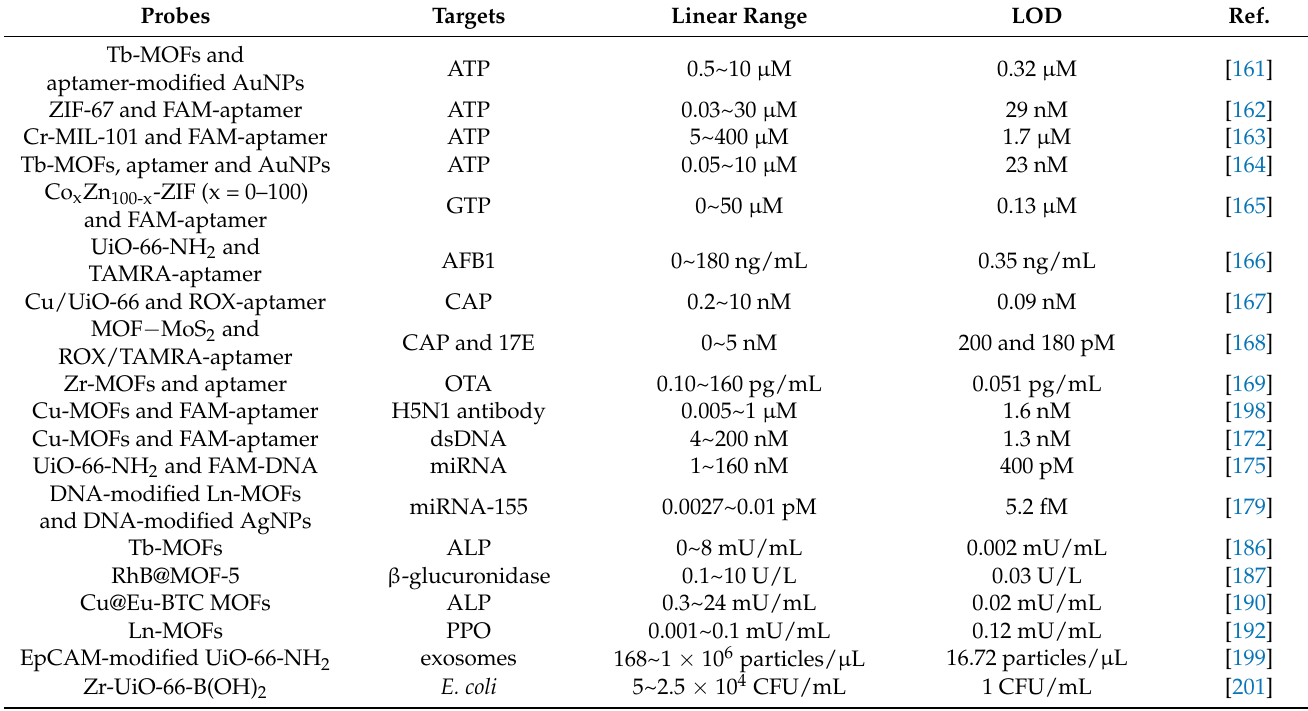
Table 3. Performances of different MOFs-based fluorescent